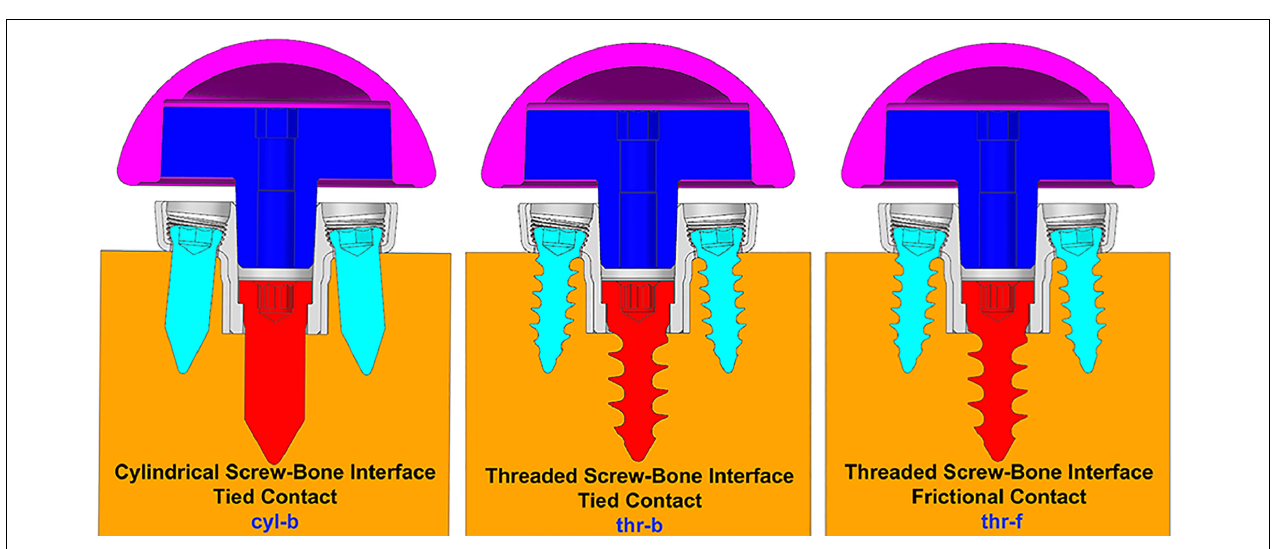
FIGURE 3 | Three modeling assumptions between the screw shafts and the bone (cross-sectional view in sagittal plane).